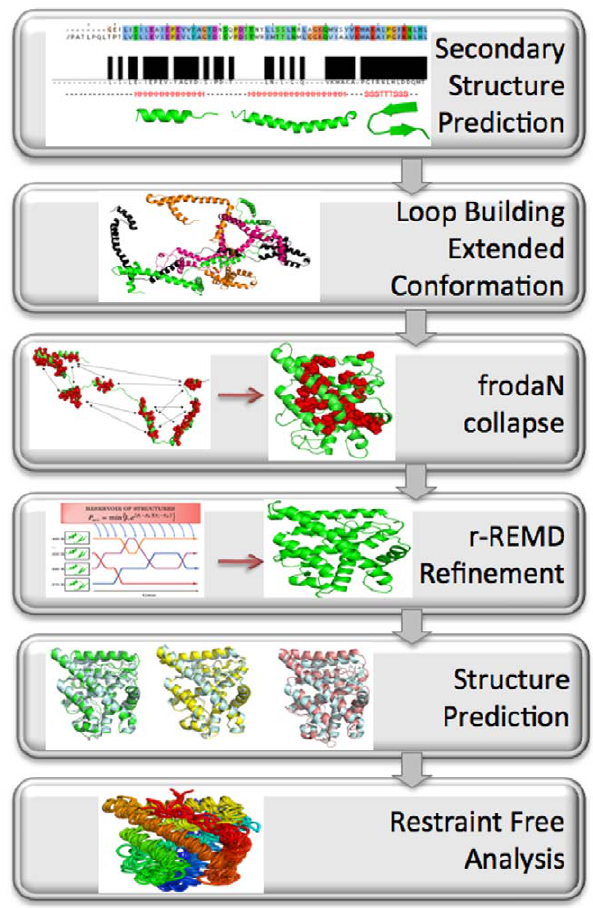
Figure 5. The secondary structure is predicted through multiple sequence alignment with modern day homologs. These secondary structural elements are then connected with loops in extended conformation to generate hundreds of conformations with high flexibility. Only a few are shown here. These structures all undergo a FRODA simulation which collapses them by adding attractive perturbations between all hydrophobic contact pairs (represented by arrows) into tightly packed structures with hydrophobic cores. A subset of hydrophobic residues are shown as spheres. After scoring, the collapsed structures they are ran in a restrained r-REMD simulation for 5 ns and then an unrestrained REMD simulation for 5 ns or until converged. The 3 ancestral structures are prediction to within 2.7 A ˚ all atom RMSD of a similar experimentally determined structure. The final ensemble of restraint free generated structures are analyzed for dynamics using PCA.